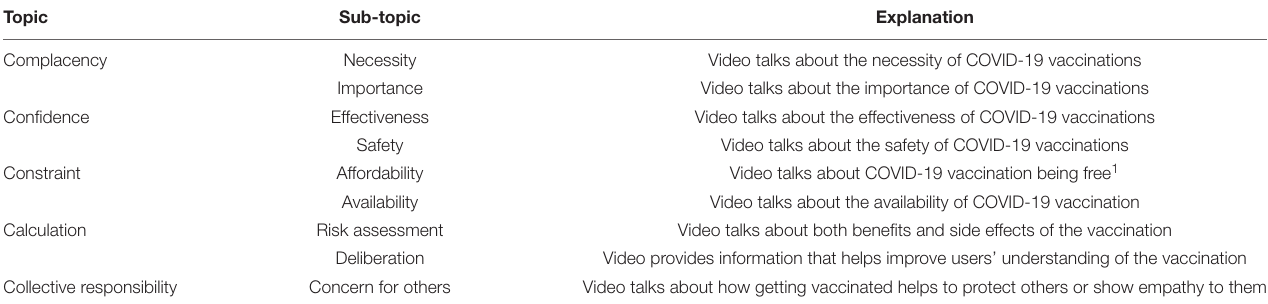
TABLE 1 | Vaccine beliefs expressed in TikTok